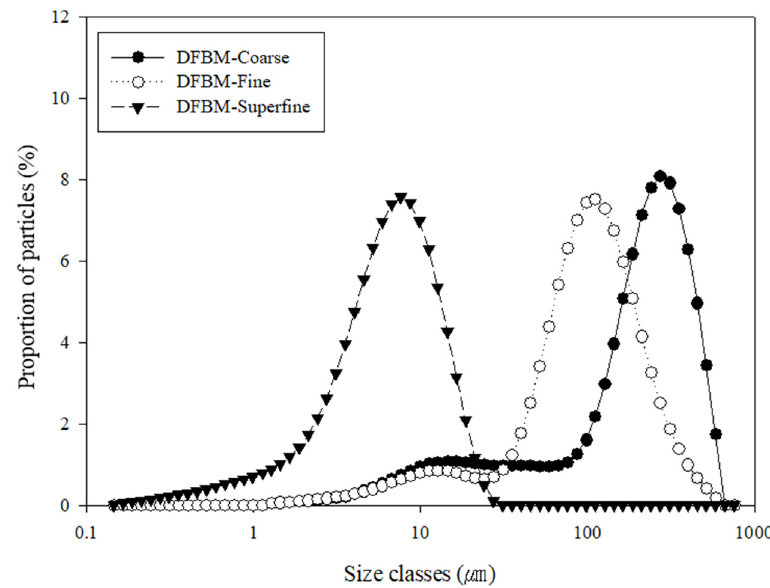
Figure 3. Particle size distribution of coarse, fine and superfine mushroom powders. The white button mushrooms were UV-B treated for 30 min and freeze-dried before pulverization.